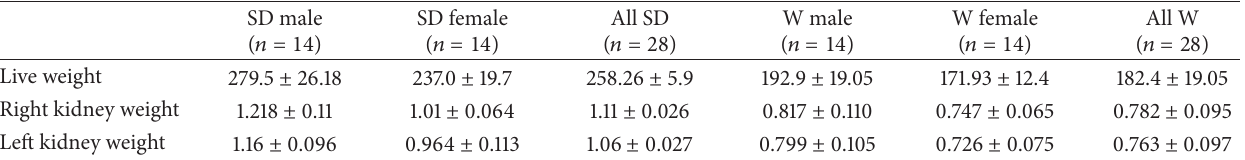
Table 1: Comparative morphometric values of the kidney in Wistar and Sprague-Dawley rat (mean ± SEM). SD male